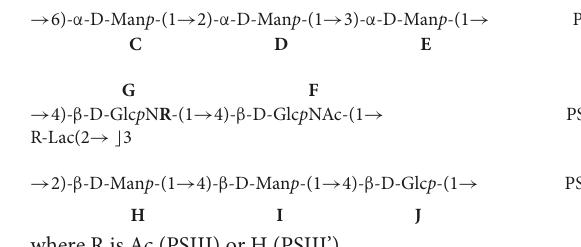
to δ 73.2 for non-substituted GlcNAc C-3), thus confirming